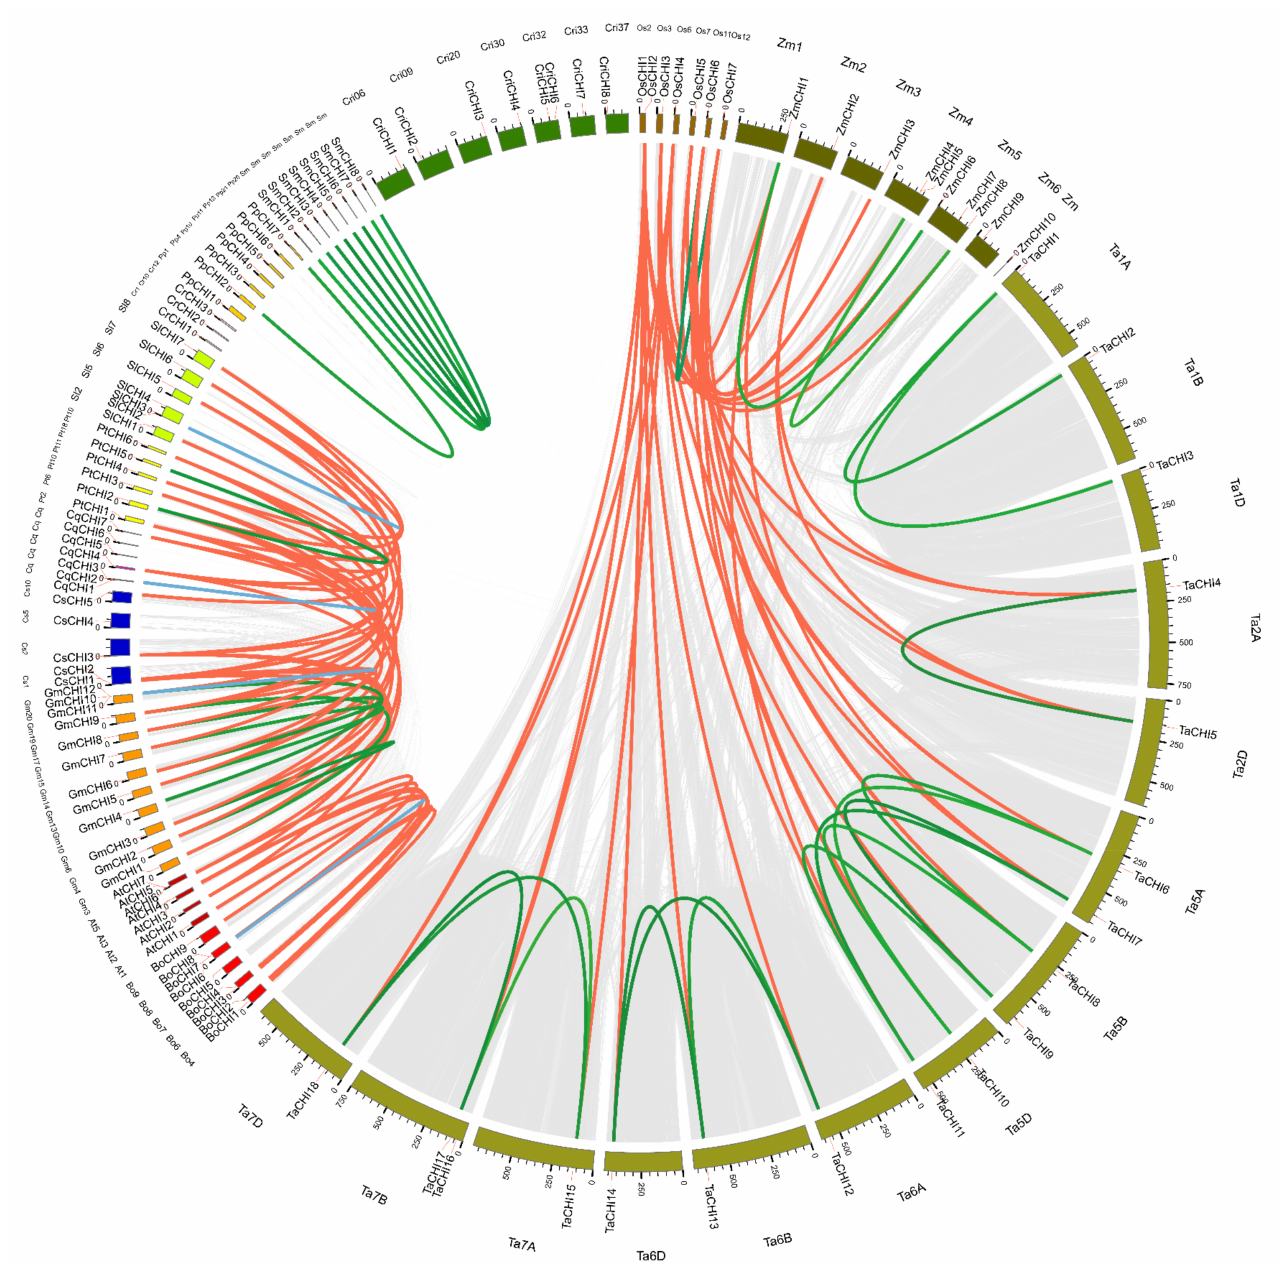
Figure 3. Extensive microcollinearity of CHI gene pairs across green plants. The circle plot was created by Circos software. The chromosomes in each plant are indicated by different colors. Os, Zm, Ta, At, Bo, Cq, Cr, Cs, Gm, Pp, Pt, Sl, Sm, and Cri represent O. sativa , Z. mays , T. aestivum, A. thaliana , B. oleracea , C. quinoa , C. reinhardtii , C. sativa , G. max , P. patens , P. trichocarpa , S. lycopersicum , S. moellendorffii and C. richardi , respectively. Blue and green curved lines separately represent tandem and segmental duplication events, and red curved lines indicated the syntenic relationships between inter-species. Only the chromosomes containing CHI genes were used in the analysis. The scale along each chromosome is in mega base pairs